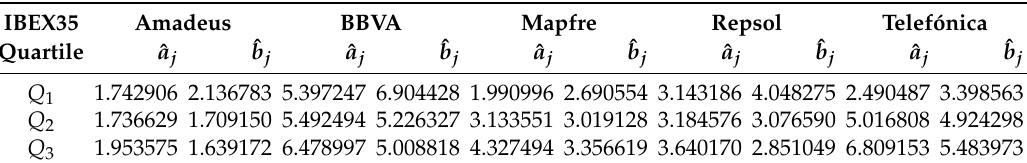
Table 7. Parameter ( a j , b j ) of the conditional stock return distributions for given IBEX35 values.